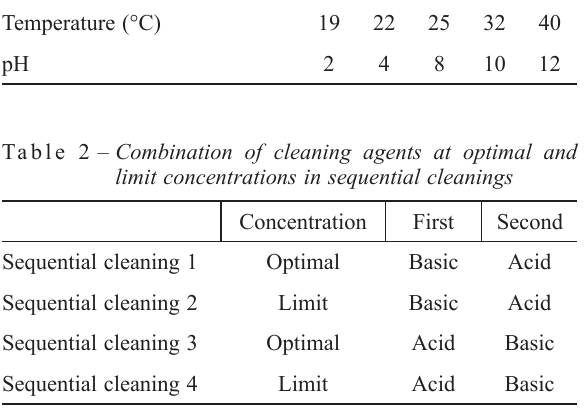
Table 1 – Different concentrations of each reagent used sep- arately in cleaning test Cleaning reagent